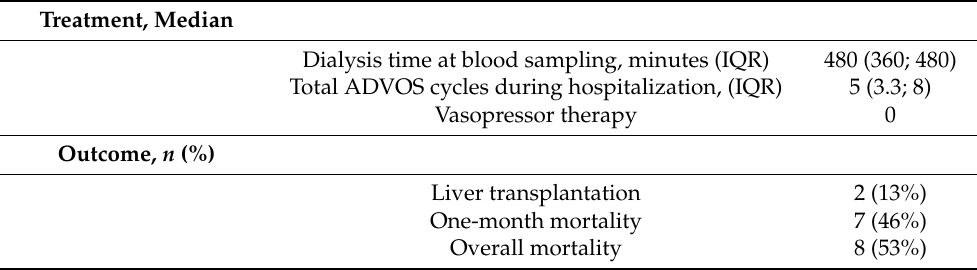
Table 3. Treatment details and outcome of included